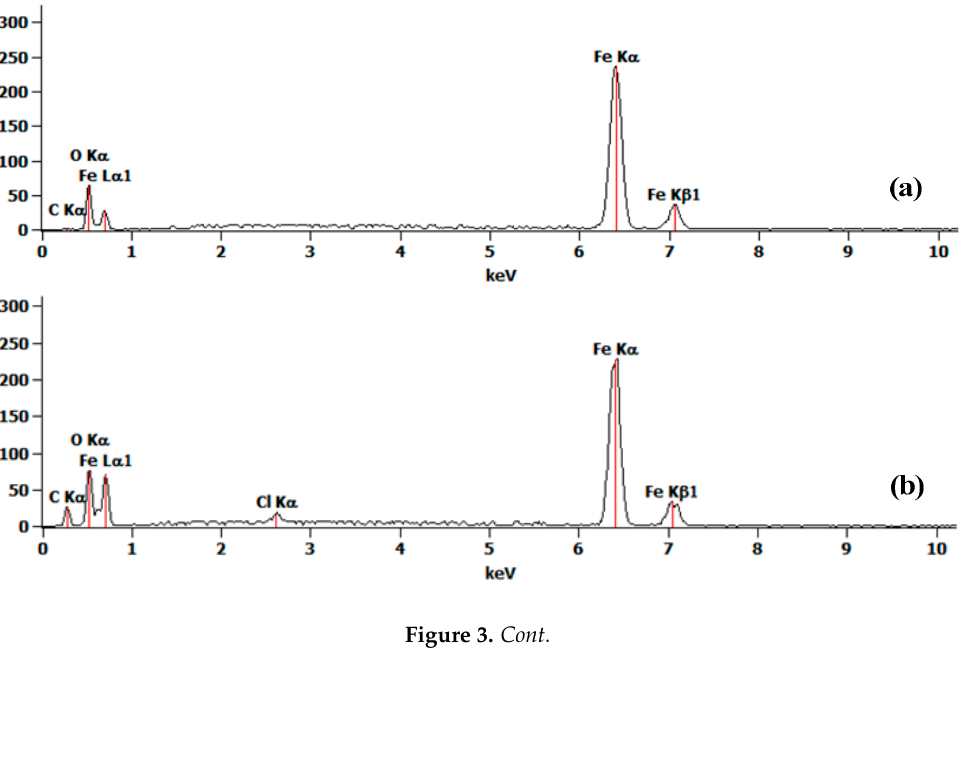
Figure 2. SEM images of nano-structures prepared at 70 °C in acidic solution for ( a ) 5 min; ( b ) 20 min, and ( c ) 30 min; ( d ) SEM image of the lotus leaf surface [35].